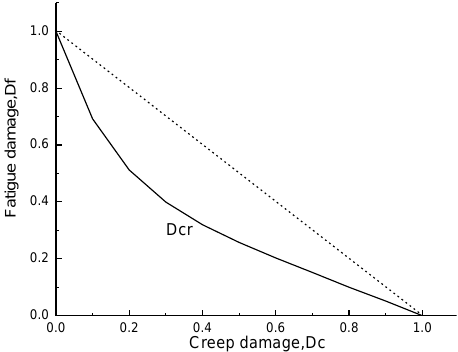
Figure 2. Curves of GH4133B fatigue–creep damage. Table 1. Distribution characteristics of input random variables.